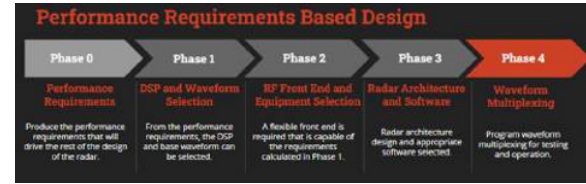
Figure 6. MIMO Radar Design Phases